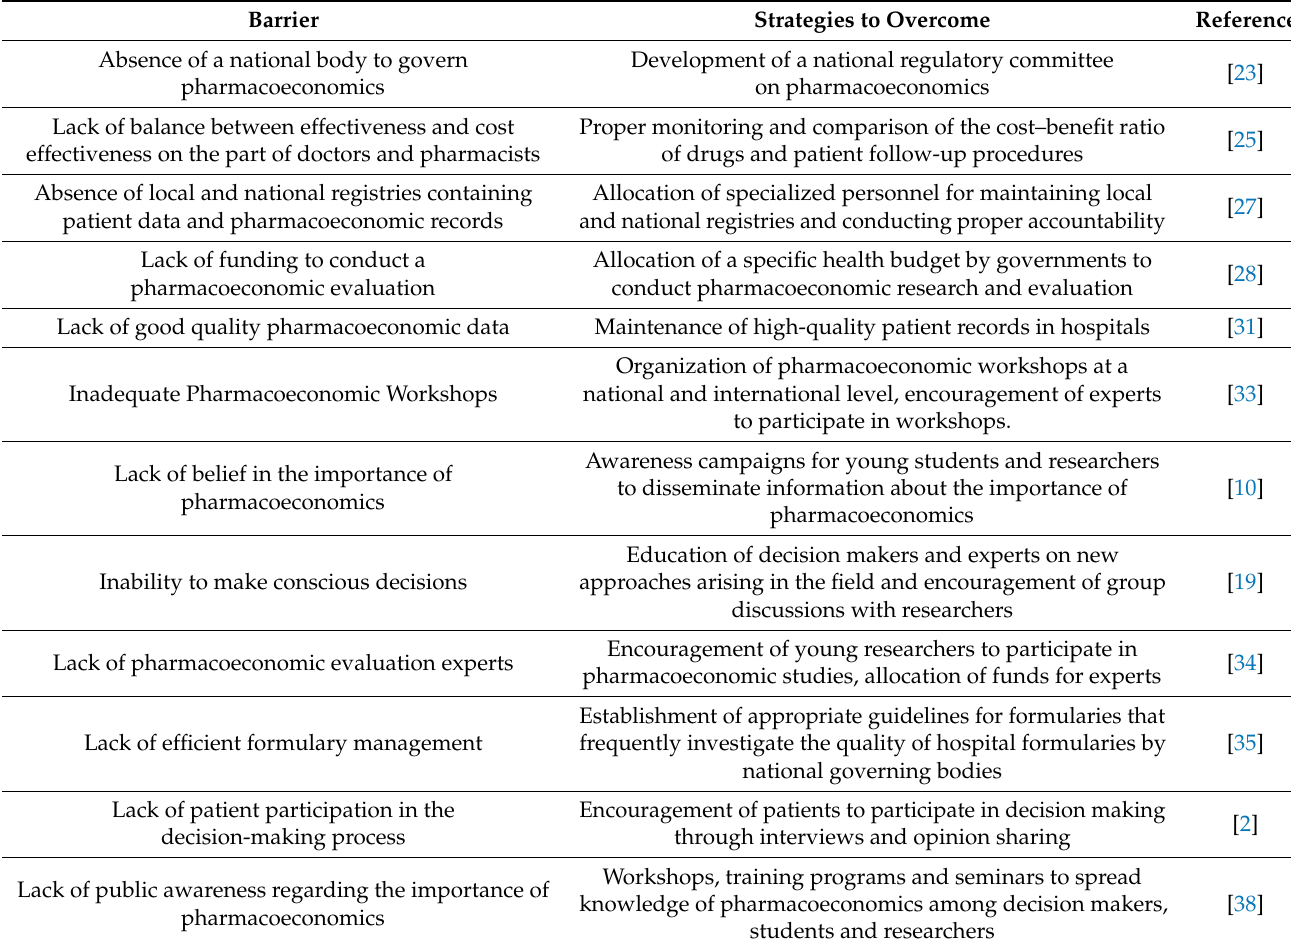
Table 1. Barriers to pharmacoeconomics and their counter strategies to overcome. Barrier Strategies to